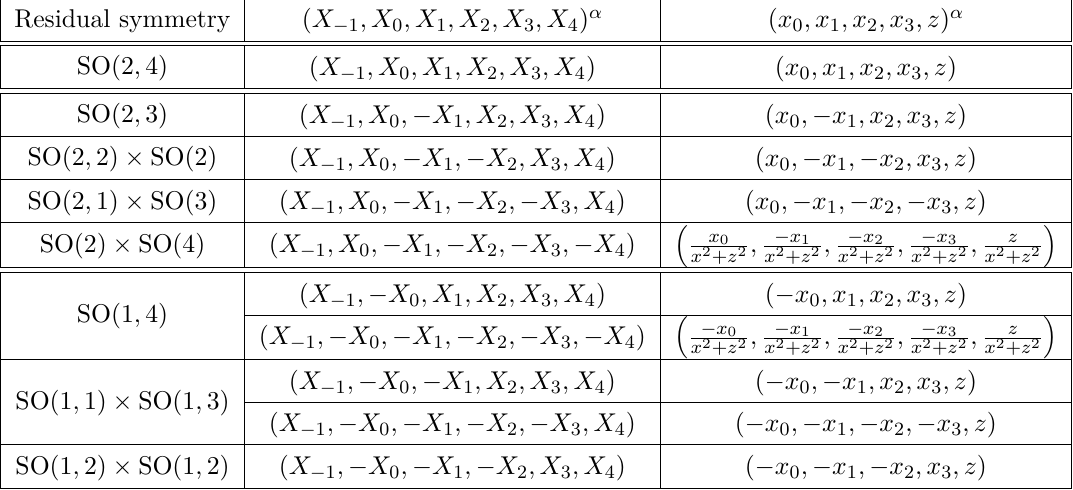
Table 2 . Crosscaps of the sigma model on AdS 5 .